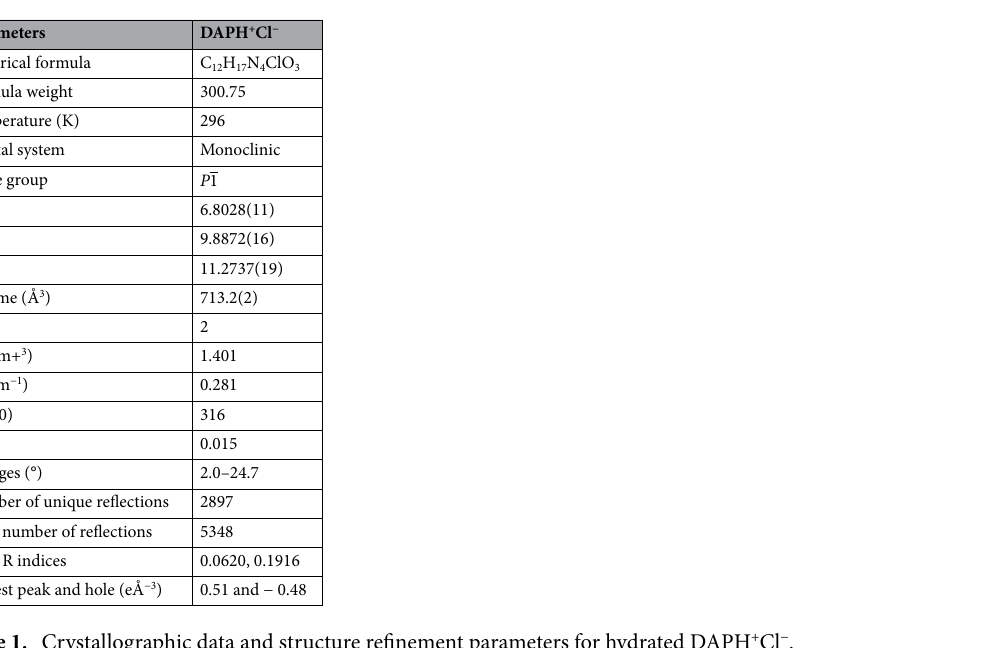
Table 1. Crystallographic data and structure refinement parameters for hydrated DAPH + Cl − .